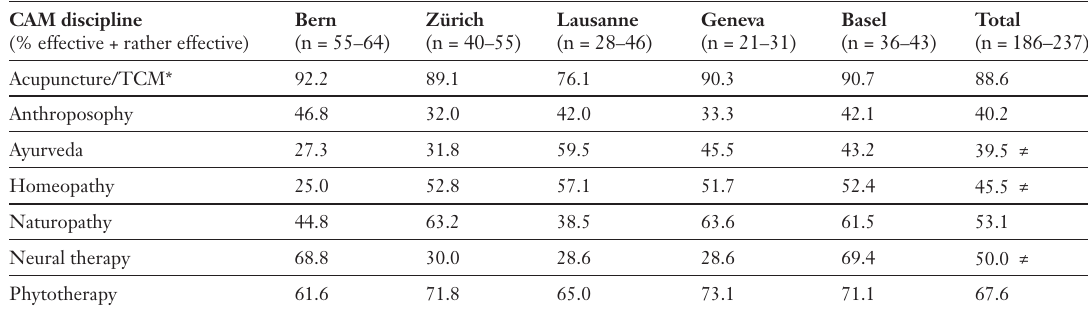
Students’ subjec- tively perceived effectiveness of